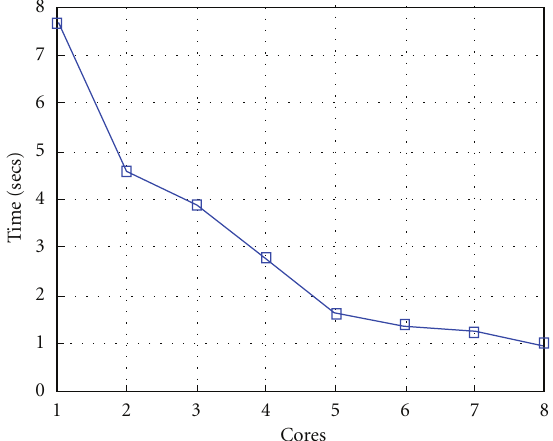
Figure 11: Test 1: Algorithm SI: Parallel e ffi ciency versus the number of cores. Δ τ = 0 . 16. 3 scale steps.